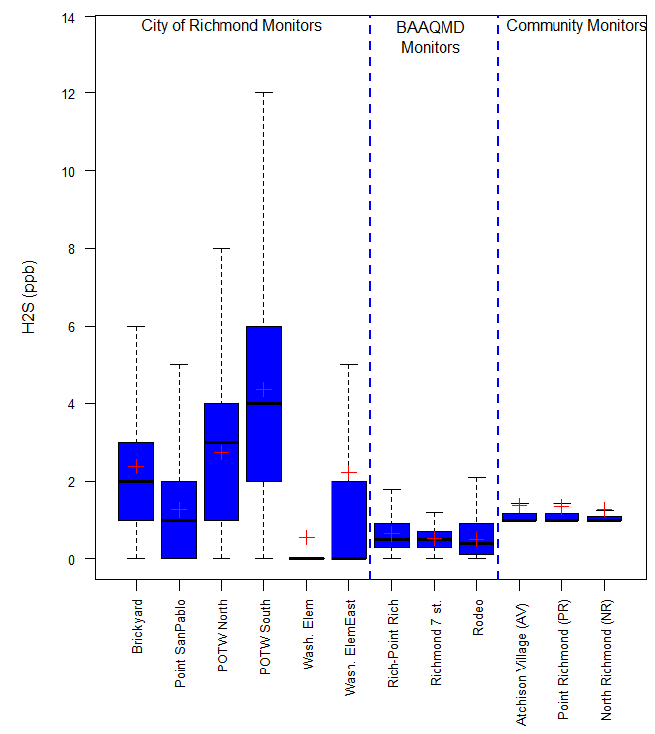
Figure 4. Distribution of 1-h averaged H 2 S concentrations at community monitors (Atchison Village, Point Richmond and North Richmond), BAAQMD stations and City of Richmond monitoring sites during 2015 – 2017 (location shown in Figure S10). Bottom and top box lines indicate the 25th and 75th percentile, respectively. Line inside the boxes and red cross represent the median and average concentrations, correspondingly. Top and bottom whisker represent the first and third quartile after subtraction / addition of 1.5 times the third-first inter-quartile range.